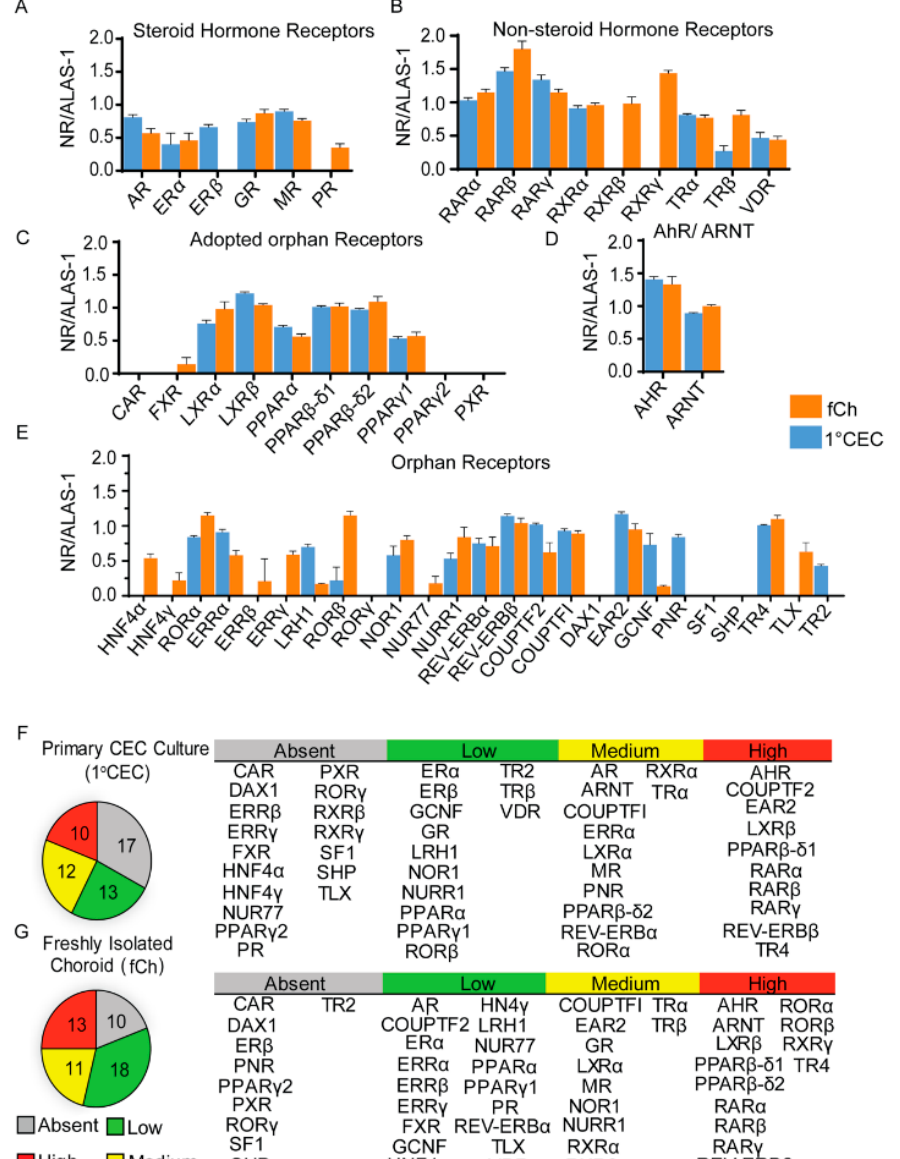
Figure 2. Nuclear receptor expression profiles by qPCR analysis of primary human choroidal endothelial cells (1 ◦ CEC) and freshly isolated human choroid (fCh). Expression profiles of nuclear receptors and related transcription factors are categorized into steroid hormone nuclear receptors ( A ), non-steroid hormone receptors ( B ), adopted orphan nuclear receptors ( C ), AhR and ARNT ( D ), which are not classical nuclear receptors but important transcription factors involved in toxin clearance and orphan nuclear receptors ( E ). Data for nuclear receptors are presented as mean arbitrary expression ratios ± SEM for 1 ◦ CEC and fCh. The levels of nuclear receptor expression in 1 ◦ CEC ( F ) and fCh ( G ) are displayed in pie charts on the left, and the nuclear receptor common names are listed according to their detectable levels on the right. Normalized nuclear receptor mRNA expression levels were defined as absent if the Ct value was ≥ 35, low if the level was less than 0.75, medium if the level was between 0.75 and 1.0, and high if the level was greater than 1. NR = nuclear